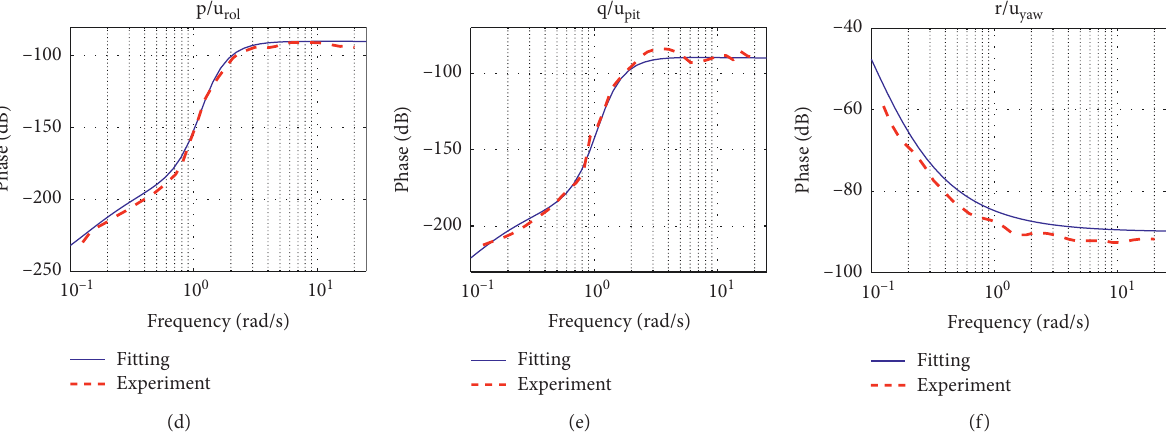
Figure 9: Frequency response identification results of angular